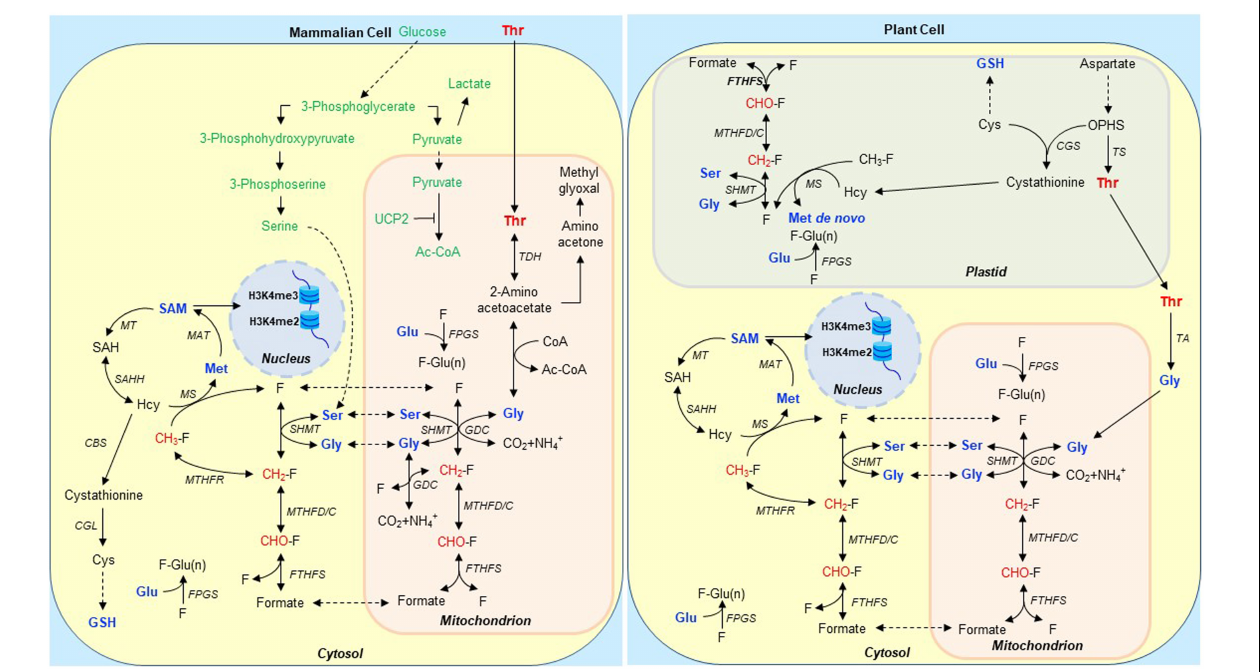
FIGURE 1 | Schematic representation of Thr and 1C metabolism in mammalian and heterotrophic plant cells involved in stem cell maintenance. We propose that Thr is taken up by a subpopulation of perinuclear mitochondria specialized to metabolize it to formate in mammalian ES cells. The mitochondria then release the formate to a compartment used specifically for H3K4me di- and tri-methylation via S -adenosyl methionine (SAM) 1-carbon (1C)-dependent metabolism (Van Winkle and Ryznar, 2019b). When the GDC is inhibited, it is unable to complete Thr catabolism. Thus, H3K4me3 formation is suppressed, and the 2-amino acetoacetate produced from Thr is instead converted to methylglyoxal which fosters ES cell senescence (Kang et al., 2019; Tian et al., 2019). Expression of enzymes in the serine synthesis pathway in TDH-deficient hES cells is up-regulated likely to circumvent the need for Thr metabolism via TDH (Tian et al., 2019). This specific pathway in hES cells is shown in green in mammalian cell; a similar pathway in plant cell is not shown. In most mammalian ES cells, serine derived from glycolytic intermediates acts as a major source of 1C units (Tibbetts and Appling, 2010). In heterotrophic plant cells, Thr is synthesized in undifferentiated and non-photosynthetic plastids. Folates (F) and their polyglutamylated forms are accumulated in plastids, mitochondria, and the cytosol. Polyglutamylated folates [F-Glu(n)] are the preferred cofactors for 1C enzymes, and FPGS mediates the addition of Glu residues to folate derivatives. Thr synthesis and polyglutamylated folates are critical for stem cell maintenance (Reyes-Hernández et al., 2014; Reyes-Hernández et al., 2019; see also Figure 2 ). Groups marked in red are 1C units derived from Thr, Ser, Gly, and formate, which are eventually used for H3K4me2 and H3K4me3 methylations. Abbreviations: Ac-CoA, acetyl coenzyme A; CBS, cystathionine β -synthase; CGL, cystathionine γ -lyase; CGS, cystathionine γ -synthase; FTHFS, 10-formyltetrahydrofolate synthetase; FPGS, folylpolyglutamate synthetase; GDC, Gly decarboxylase complex; GSH, glutathione; Hcy, homocysteine; Met, methionine; MAT, Met adenosyltransferase; MS, Met synthase; MTHFC, 5,10-methenyl-THF cyclohydrolase; MT, methyltransferase; MTHFD, 5,10-methylene-THF dehydrogenase; MTHFR, 5,10-methylene-THF reductase; OPHS, O-phosphohomoserine; SAH, S -adenosylhomocysteine; SAHH, S -adenosyl-homocysteine hydrolase; SAM, S -adenosylmethionine; SHMT, serine hydroxymethyltransferase; TA, Thr aldolase;